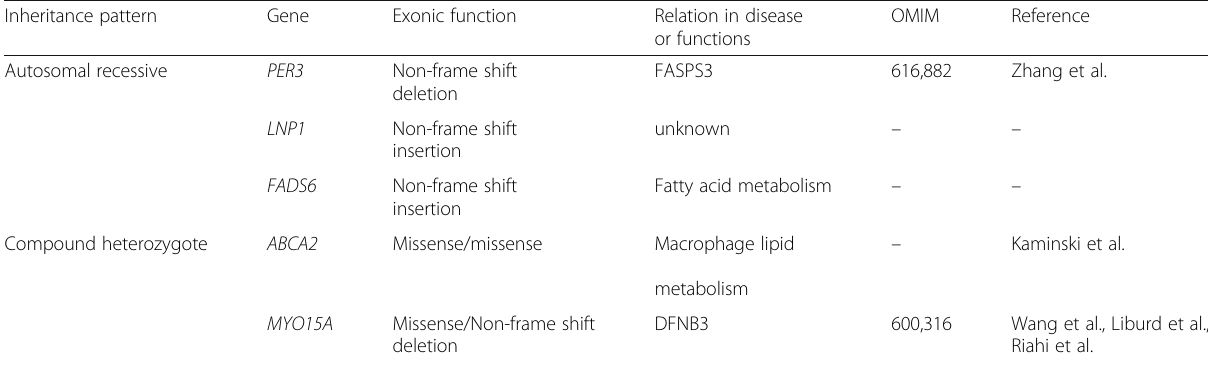
Table 2 Results of whole exome sequencing